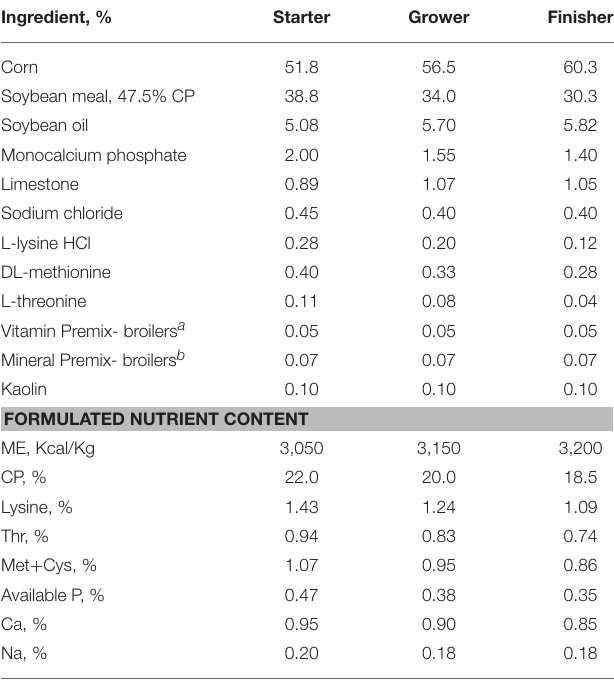
TABLE 1 | Diet formulation and nutrient